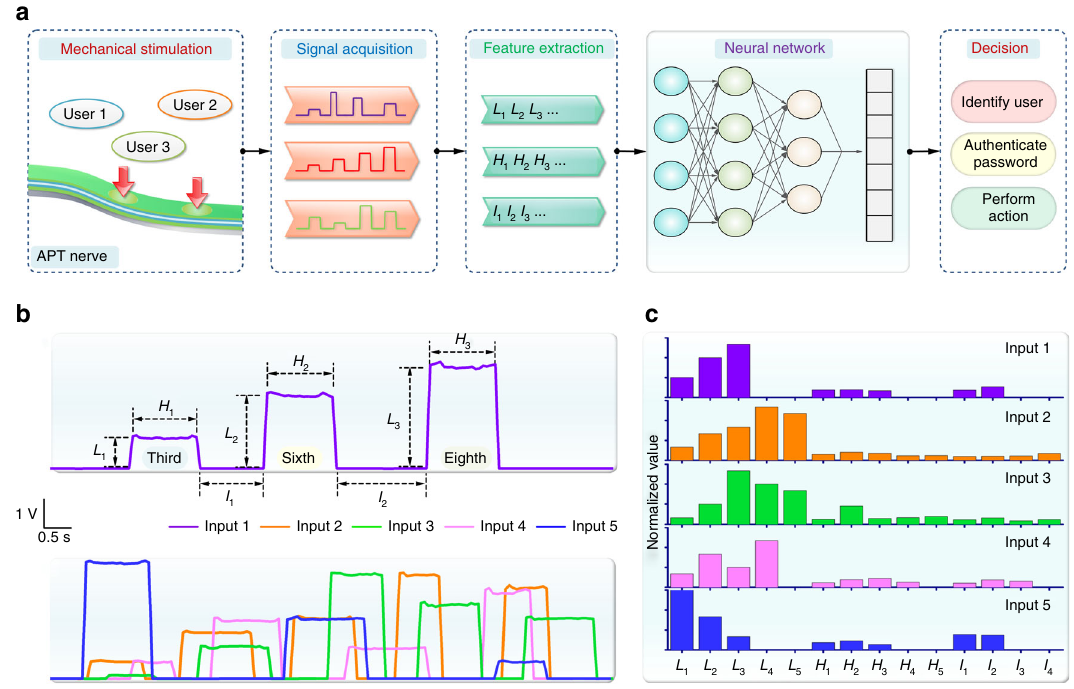
Fig. 4 The APT nerve for perceptual learning. a Schematic diagram of the machine learning based on the APT nerve, including recognition of mechanical stimulation, signal acquisition, feature extraction, decision of neural network. b Mechanosensitive signals from the APT nerve corresponding to different input information. The touching characteristic parameters included the touching location ( L ), holding time ( H ), latency interval ( I ) to characterize different mechanical stimulation within a set time (10 s). c Three-factor feature map based on the touching characteristic parameters extracted from b